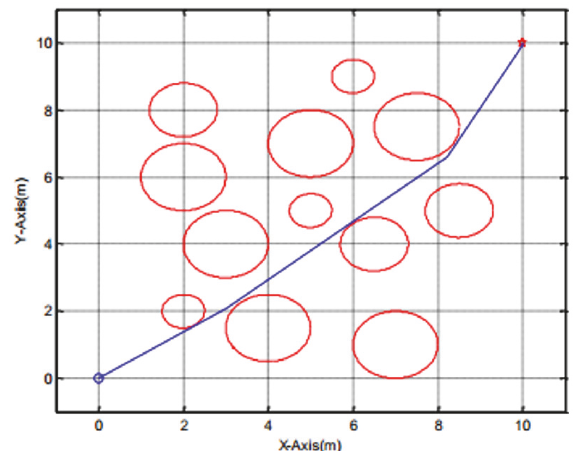
Figure 4: Best path results using DABC (source [122]).